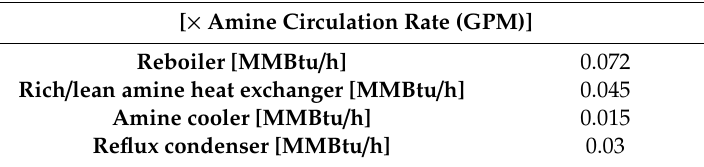
Table 5. Heating duty factor to amine circulation rate for the main equipment in the amine-based gas sweetening process [60].